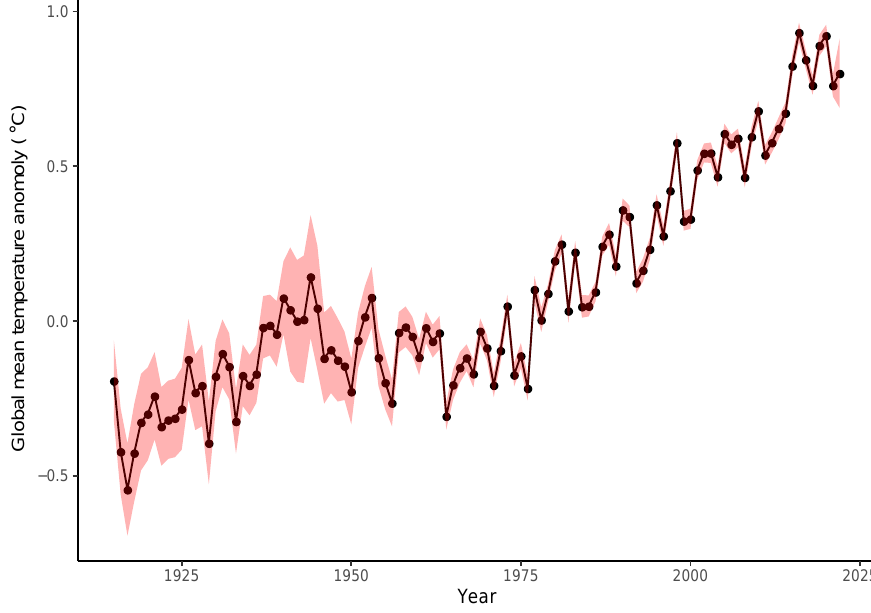
Figure 1. Global mean temperature anomalies from the HadCRUT5 dataset in 1915–2020, relative to the period 1961–1990, with associated uncertainties in red